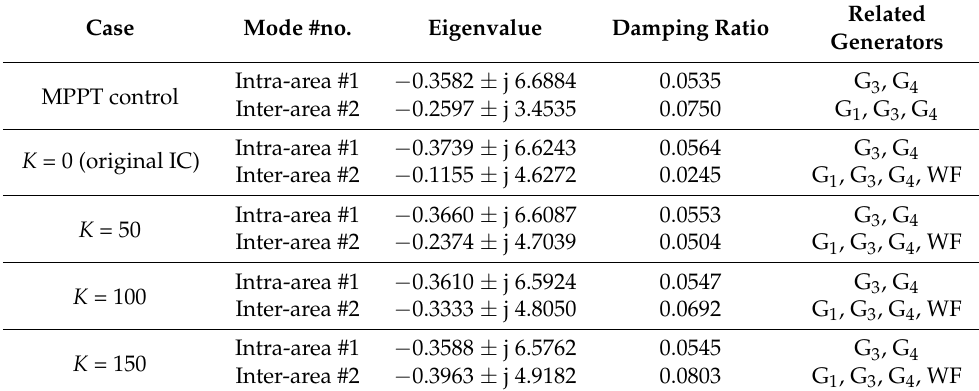
Table 3. The LFO modes of the system with different values of the damping control gain K ( K D = 40, K P =